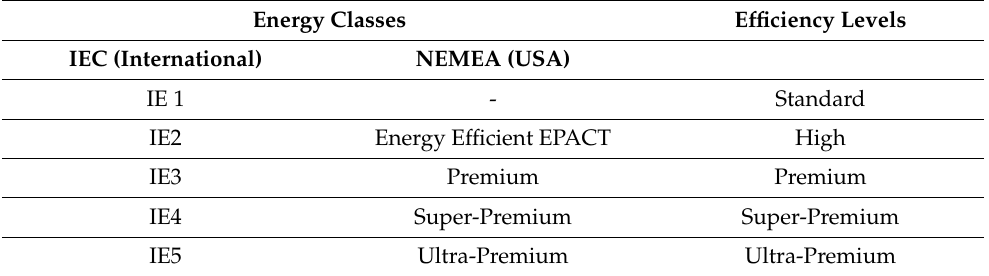
Table 2. Electrical motors efficiency classes [30,31]. Energy Classes Efficiency Levels IEC